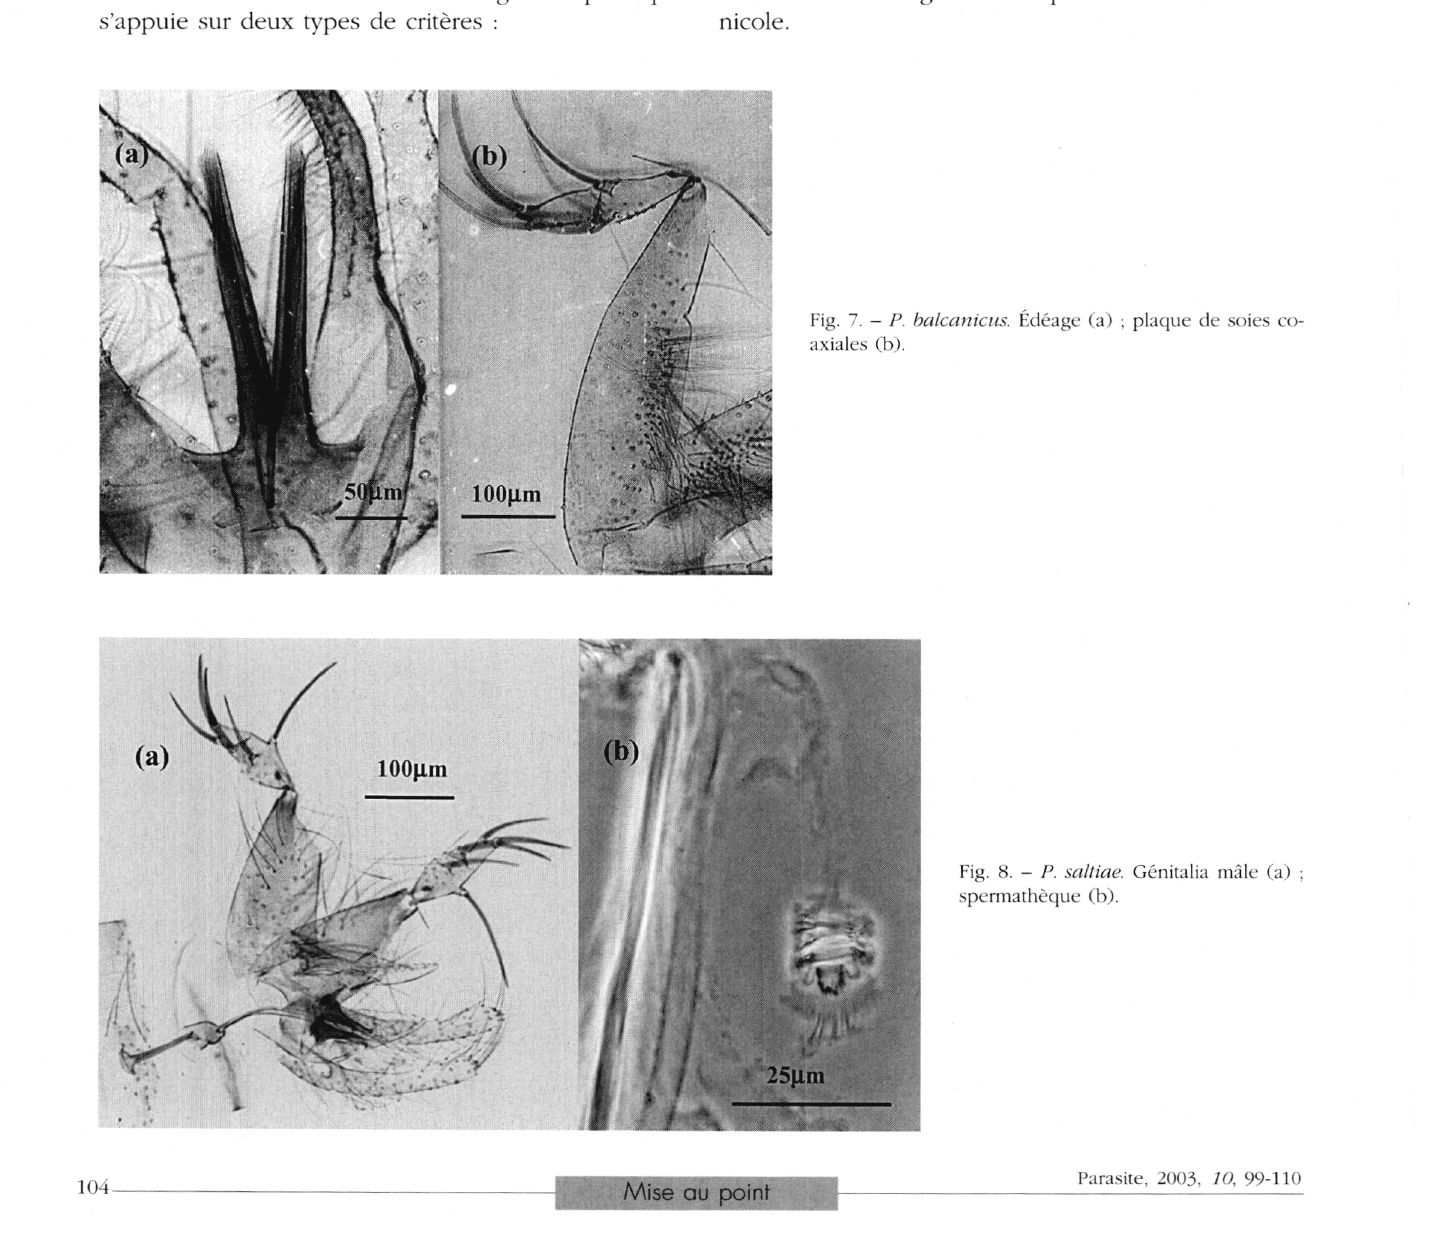
Fig. 8. - P. saltiae. Génitalia mâle (a) spermathèque